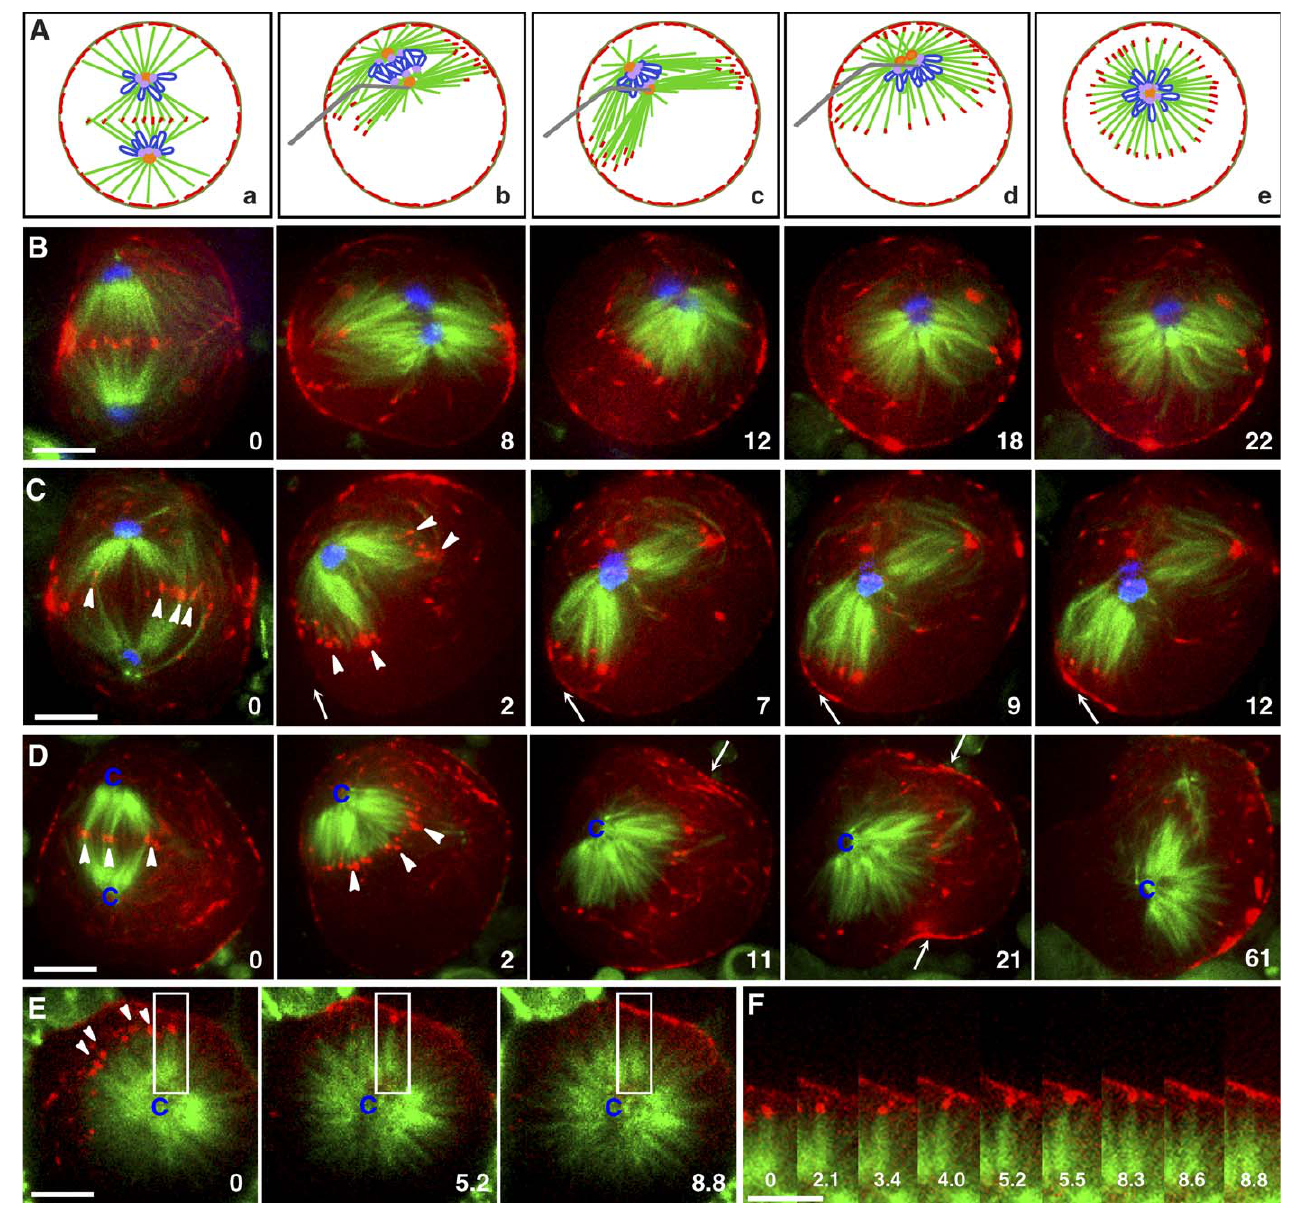
Figure 6. Redistribution of Cortical Actin, but Not Equatorial Stimulation, Was Dependent on Microtubule Dynamics (A) A schematic showing remodeling of the central spindle by micromanipulation. A post-anaphase spindle (a, green) was collapsed using a micromanipulation needle (b, gray). The manipulation created two lateral microtubule bundles, with the exposed microtubule plus ends of the bundles pointing toward opposite sides of the cortex. The interior ends of the bundles flanked chromosomes (c, blue), kinetochores (c, purple) and centrosomes (c, orange). If the collapsed spindle was brought close to the cortex and held in place by a microneedle, it reorganized into a monopolar spindle (d). If the holding needle was removed, the spindle usually reorganized into a giant aster (e). (B) Actin exclusion was inhibited when the remodeled spindle was stabilized by paclitaxel. Neither the stabilized lateral spindle (8) nor the evolving monopolar spindle (12–22) induced unidirectional flow of actin filaments (compare to Figure 3). Cells in (B–F) were labeled as in Figure 5C. (C) Actin aggregates were assembled at the plus ends of stabilized, laterally oriented microtubule bundles (0–2, arrowheads), and were delivered to the non-equatorial cortex where splaying microtubule bundles were in contact with the cortex (2–12, arrows). (D) A monopolar spindle (2) gradually splayed its microtubule bundles toward the cell cortex (2–21), which delivered actin aggregates (2, arrowheads) and induced a furrow (11–21, arrows). The furrow eventually regressed (61). (E) Tracking of an actin aggregate delivered from the plus ends of one microtubule bundle to the cell cortex. The giant aster had chromosomes in its center and microtubule plus ends pointing outward, as in (A, panel e). When the aster was placed near the cell cortex using a microneedle, an actin aggregate moved away from the microtubule bundle plus ends and merged into the cortex (box, 0–8.8). (F) The region of interest in (E) is shown with additional intervening time points to highlight the increasing cortical fluorescence caused by merging of actin aggregates. Time in min. Time 0 in (B), (D), and (E), mid to late anaphase; in (C), telophase; in (F), identical to 0 in (E). Bars, 10 l m.